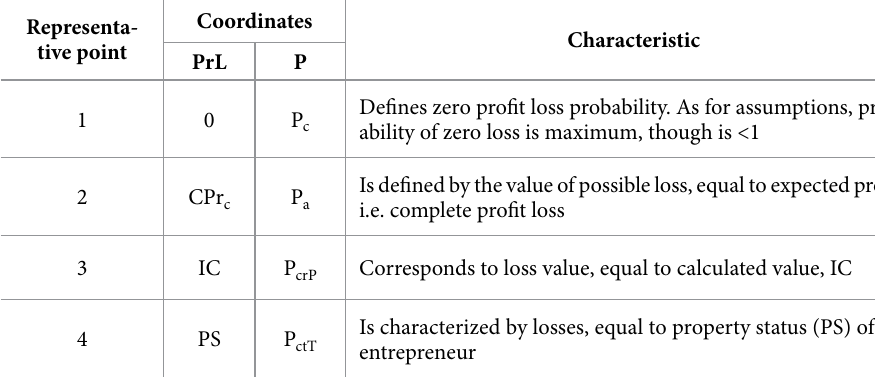
Table 1. Parameters of representative points on the risk curve Coordinates Representa- Characteristic tive point PrL P Defines zero profit loss probability. As for assumptions, prob- 1 0 P c ability of zero loss is maximum, though is <1 Is defined by the value of possible loss, equal to expected profit, 2 CPr c P a i.e. complete profit loss 3 IC P crP Corresponds to loss value, equal to calculated value, IC 4 PS P ctT